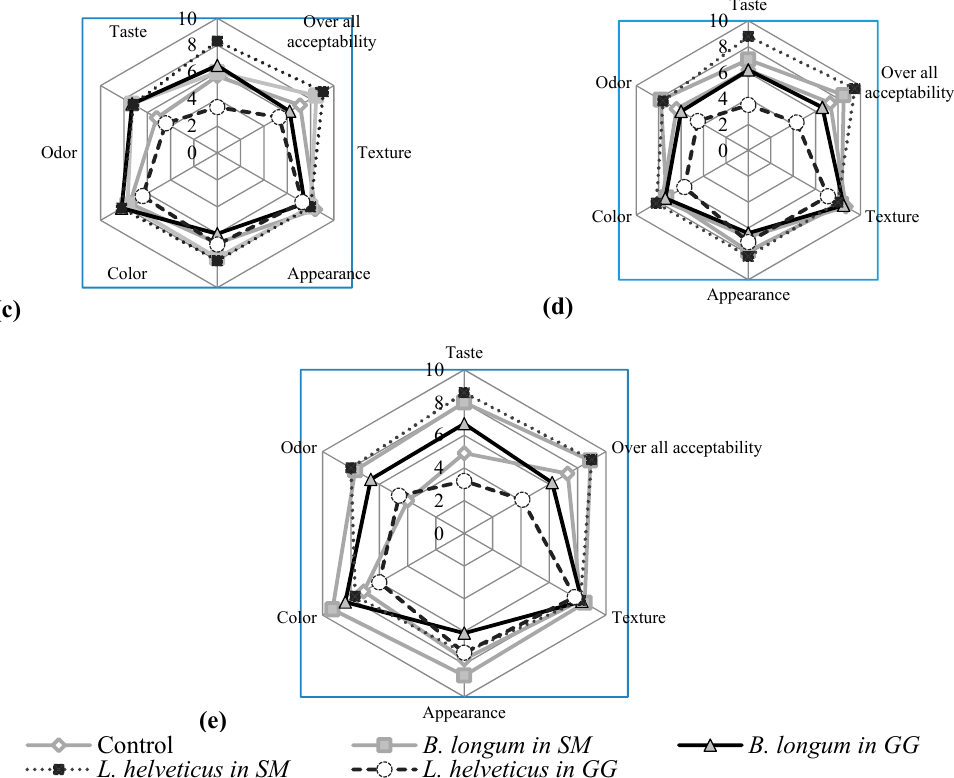
Figure 4. Sensory evaluation of probiotic potato chips during storage for 4 months at 30 °C. ( a ) At zero time, ( b ) After storage for one month, ( c ) After storage for two months, ( d ) After storage for three months and ( e ) After storage for four months.